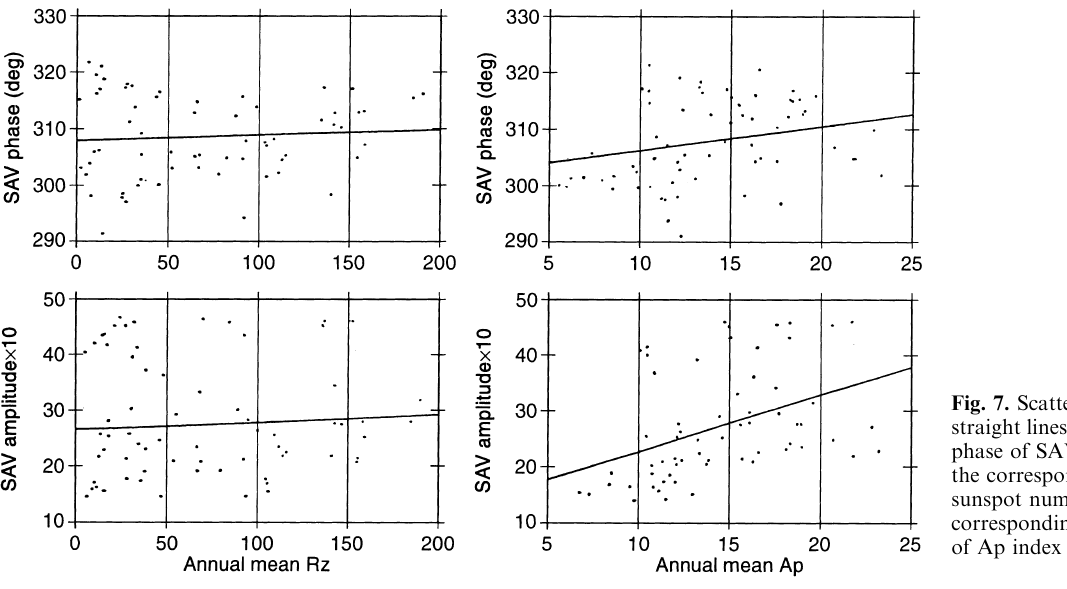
Fig. 7. Scatter plots and best fit straight lines of the amplitude and phase of SAV (for each year) and the corresponding annual mean sunspot number ( left ) or the corresponding annual mean value of Ap index (